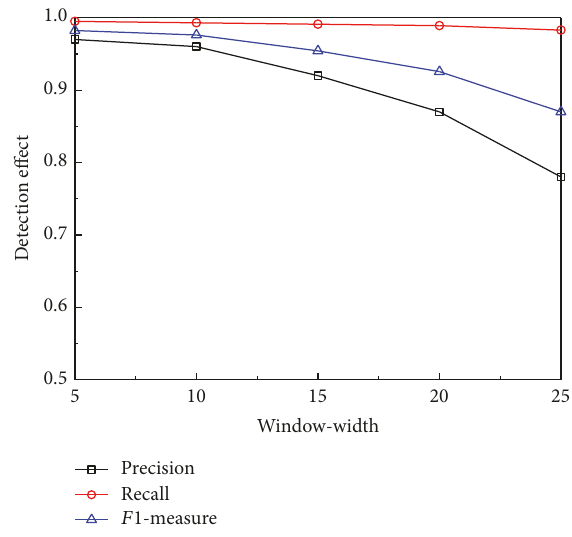
Figure 4: Influence of sliding window size on the test